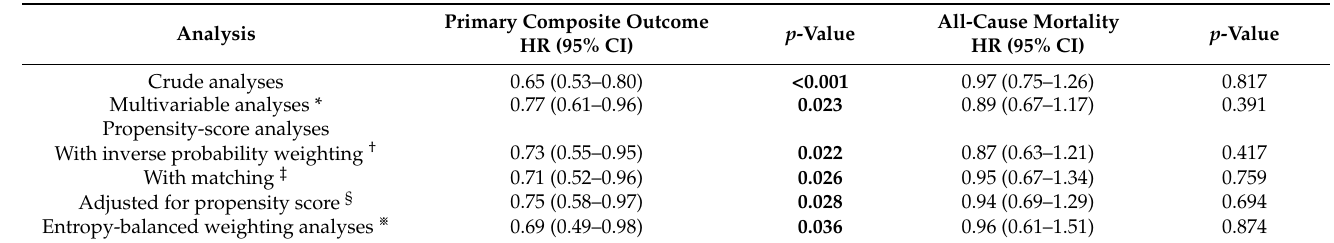
Table 2. Associations between Hypertension diagnosis and the primary composite endpoint of VA and all-cause mortality in the crude analysis, multivariable analysis, propensity-score analysis, and entropy-balanced analysis.